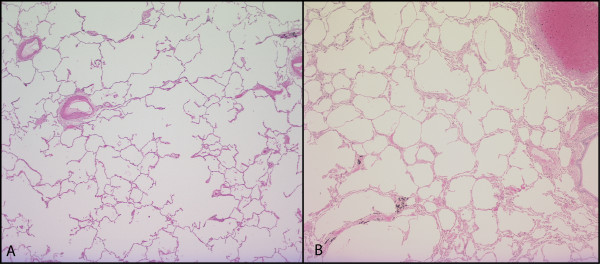
Hematoxylin and Eosin-stained Images of Tissue Samples A and B in Figures 2, 3. The tissue shown in A has a SA/V of 247 mm2/mm3 and a CT density of 0.14 g/ml while the area in B has a SA/V of 258 mm2/mm3 and a CT density of 0.24 g/ml. Thus despite comparable SA/V, there is a substantial difference in CT density due to the deposition of extracellular matrix in B. On the other hand, CT cluster analysis (i.e., value D), which relies solely on the size of the low attenuation areas, was comparable in these two regions (0.97 in A and 1.17 in B).